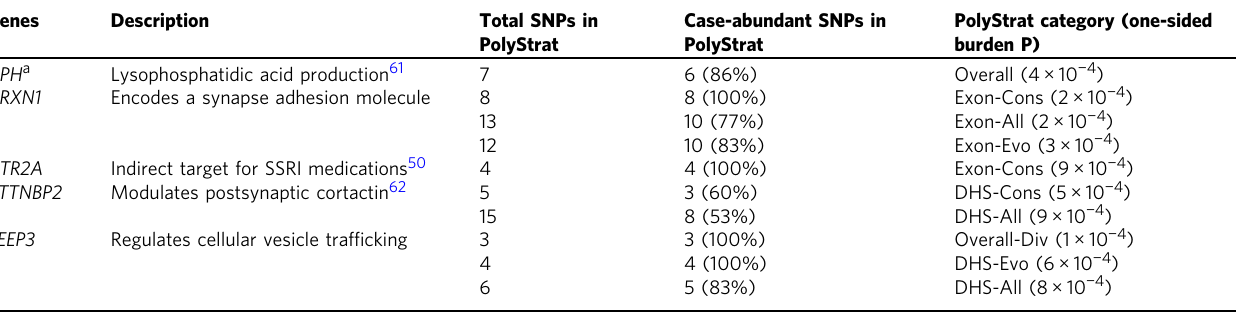
Table 1 Five genes with signi fi cant variant burden in OCD cases in pooled sequencing data